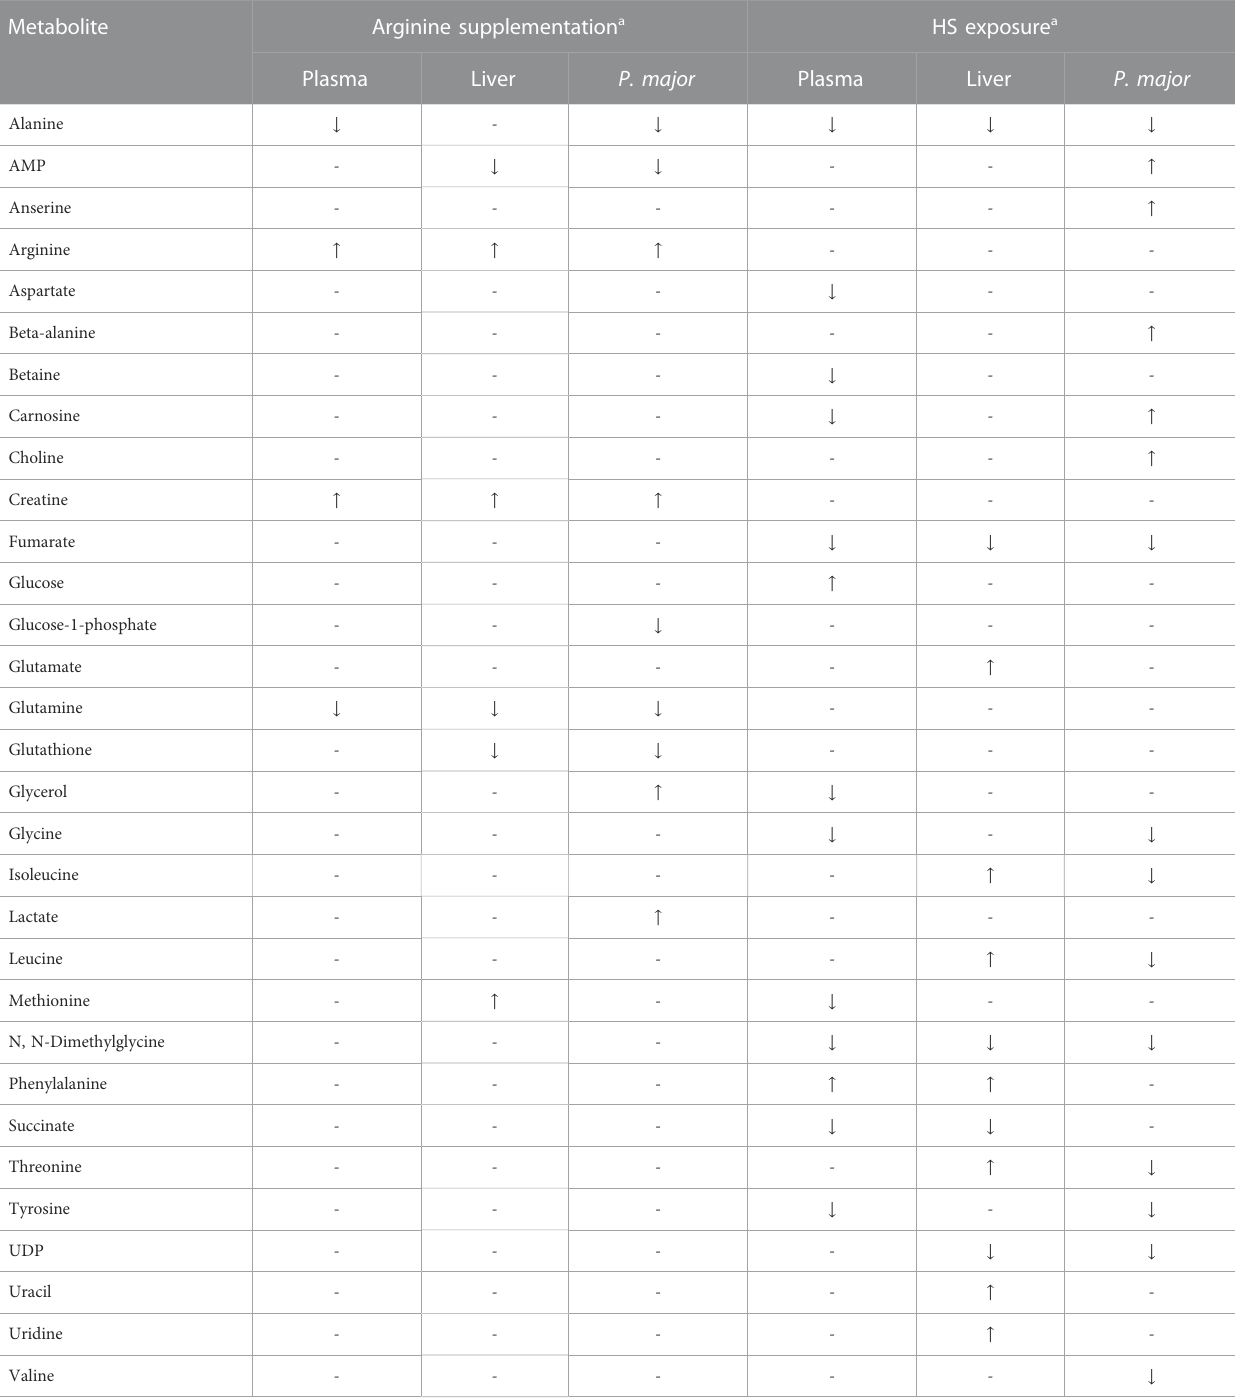
TABLE 3 Biologically relevant metabolites whose concentration was affected ( p -values of 0.1 maximum) by either arginine supplementation, HS exposure or both (see Supplementary Tables S1 – S3 for more information).